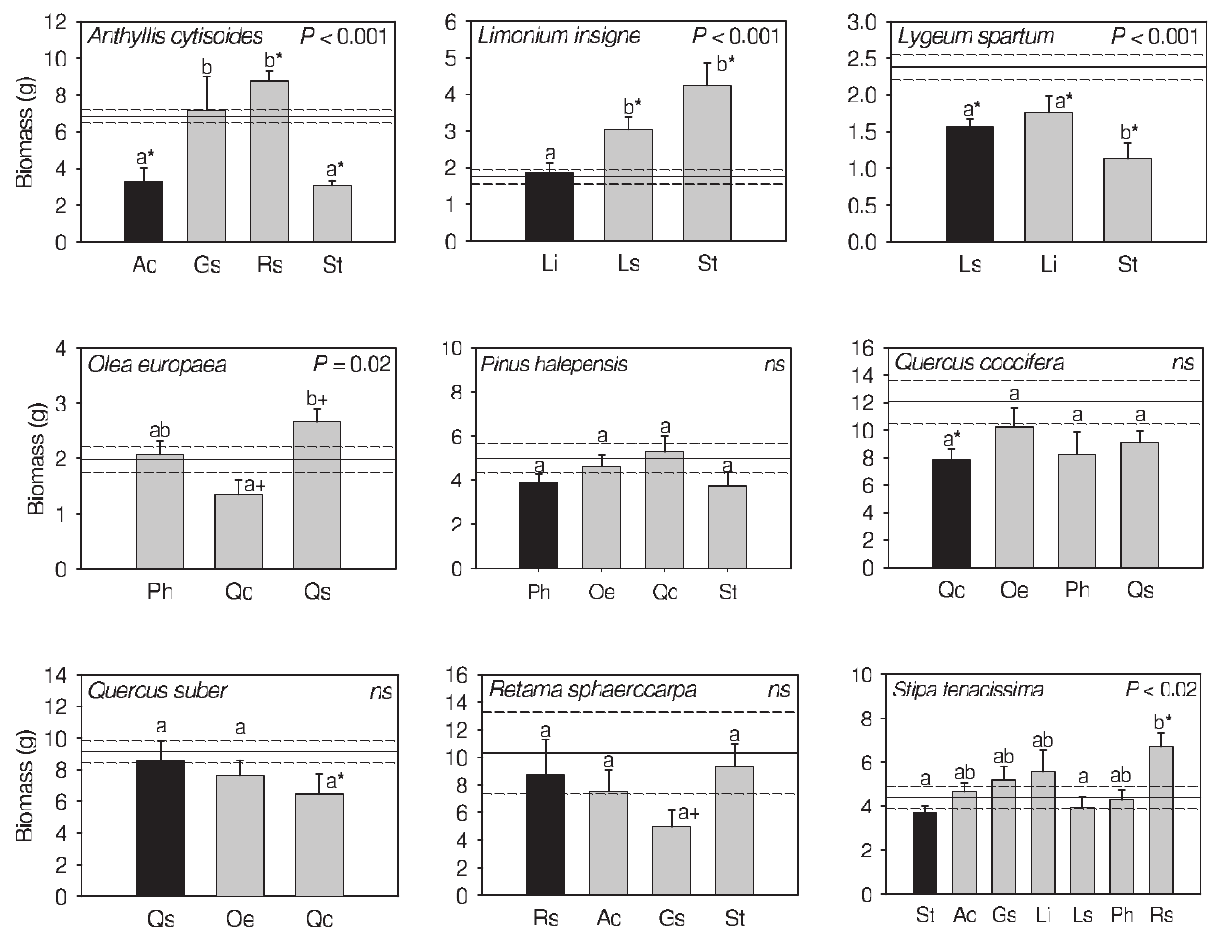
Figure 1. Total mass of individuals of target species (name inside the panel) growing in association to individuals of the same (solid column) or different species (grey column). P is the significance from ANOVA ( ns : non-significant differences). The continuous horizontal line shows the mean mass of control plants and dashed lines represent 6 1 SE. Bars with different letters are significantly different at P , 0.05. * ( P , 0.05) and + ( P , 0.07) show differences with control plants. Legend of species is as in Table